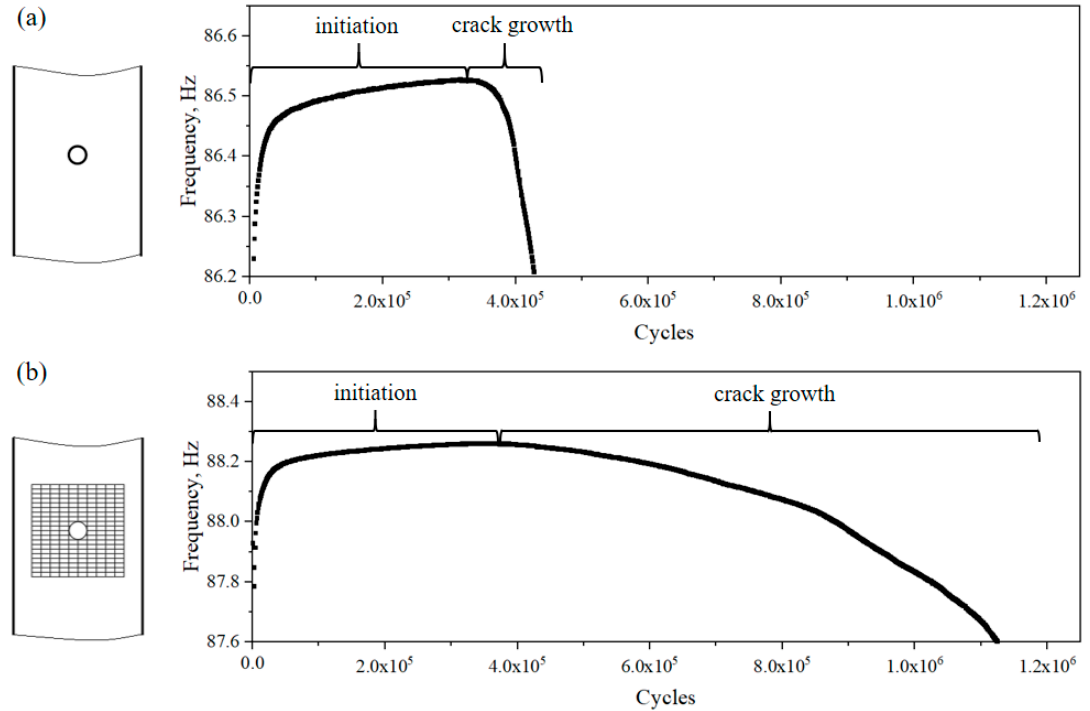
Figure 9. ( a ) Frequency graph of a base material specimen with a fastener hole. ( b ) Frequency graph Figure 9. (a) Frequency graph of a base material specimen with a fastener hole. (b) Frequency graph of a specimen treated first by LSP, and subsequently, a fastener hole is introduced.